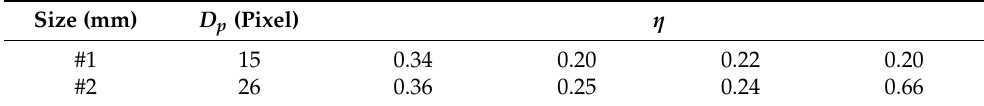
Table 3. Impact defect location detection accuracy.